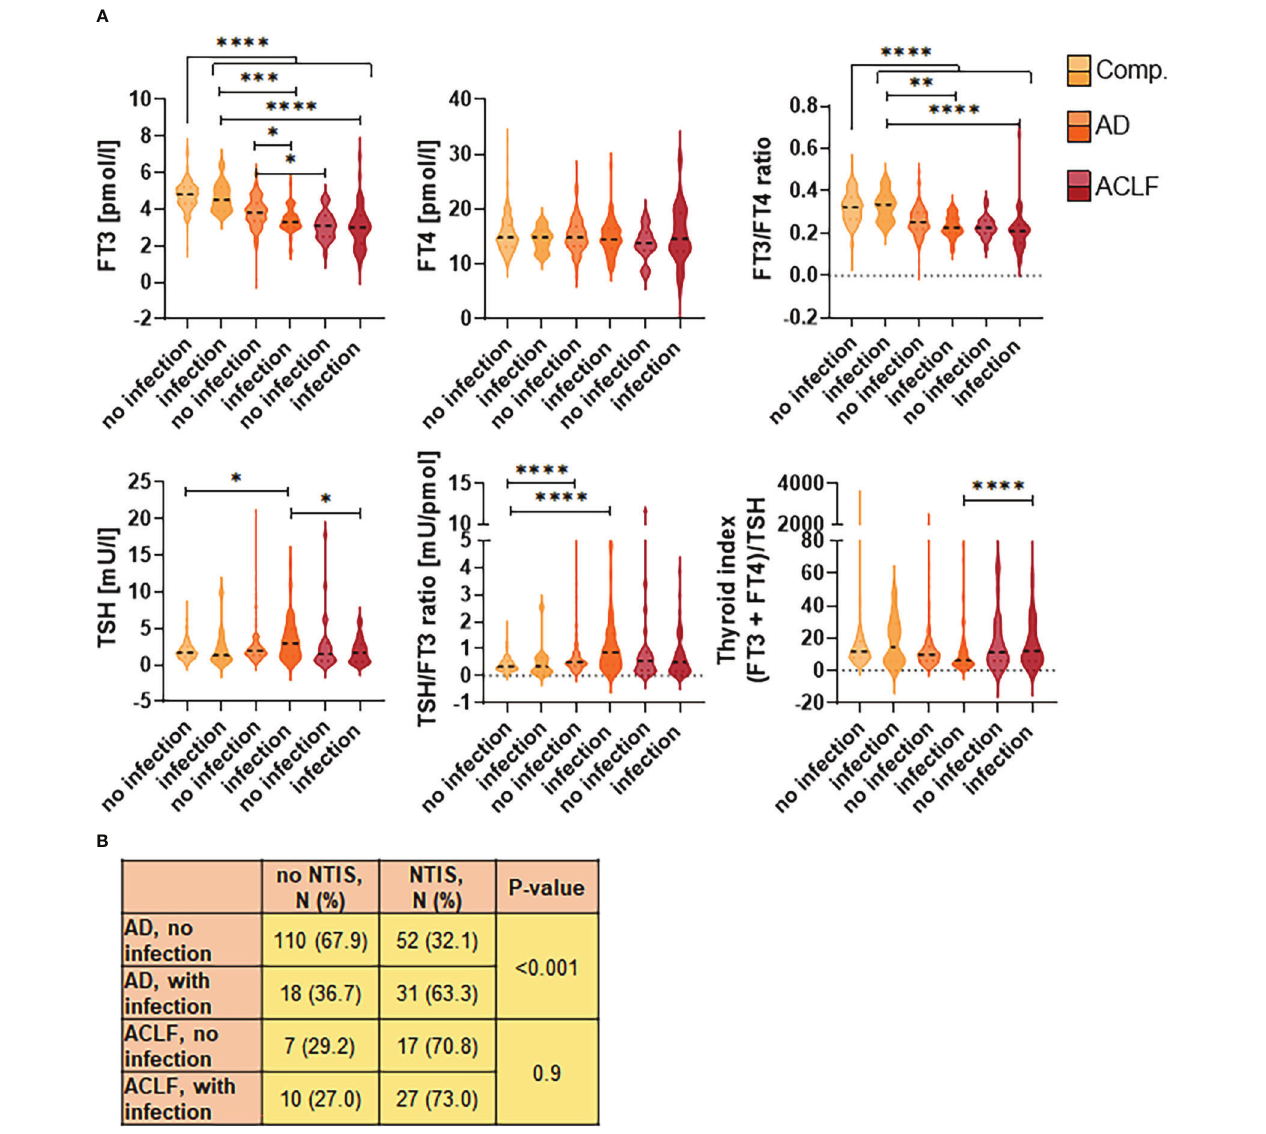
FIGURE 2 Impact of infections on thyroid hormones. (A) Violin blots of thyroid hormone concentrations are shown for patients with or without infections according to the stage of liver cirrhosis. Graphs show value distribution with median (black dashed line) ± quartiles (colored dashed lines). One-way ANOVA or Kruskal-Wallis test were used as appropriate after Normality Test. *P ≤ 0.05, **P ≤ 0.01, ***P ≤ 0.001, ****P ≤ 0.0001. (B) Frequencies of non- thyroidal illness syndrome (NTIS) in patients with or without infections. ACLF, acute-on-chronic liver failure. AD, acute decompensation; Comp., compensated cirrhosis; FT3, free triiodothyronine; FT4, free tetraiodothyronine; TSH, thyroid-stimulating